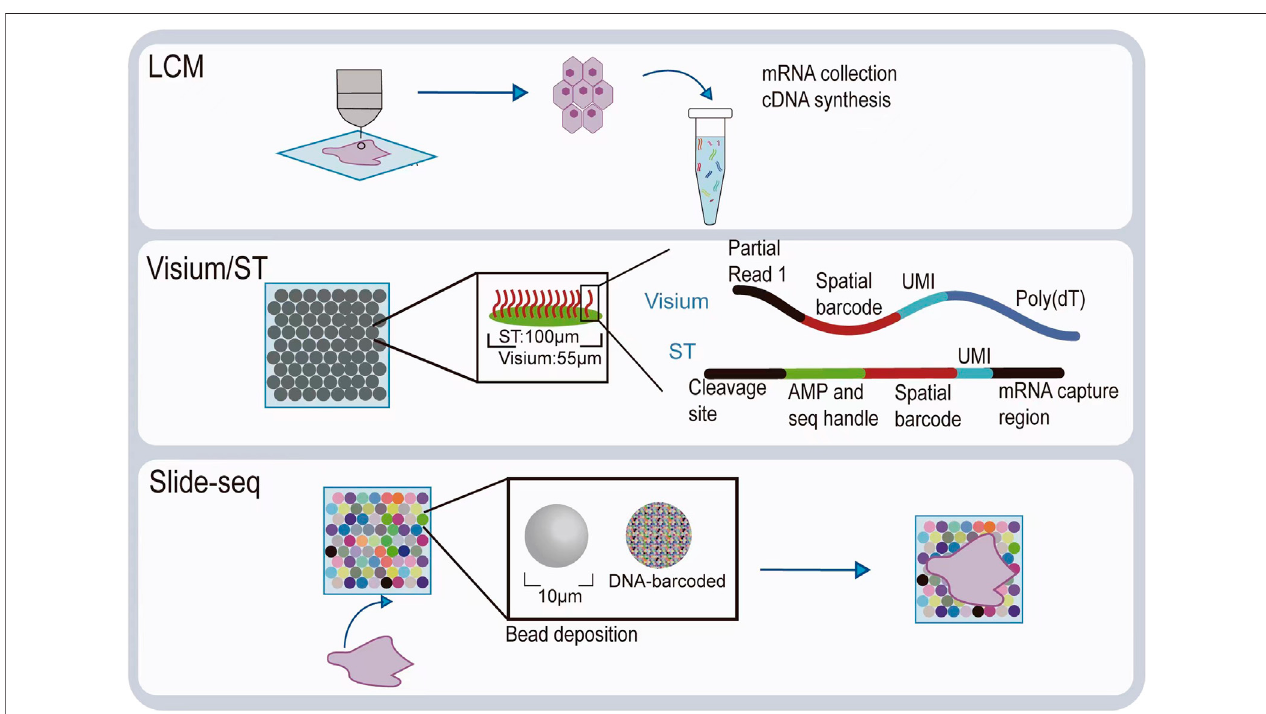
FIGURE 3 | Illustration of spatial transcriptomic technologies based on in situ capture and next-generation sequencing.